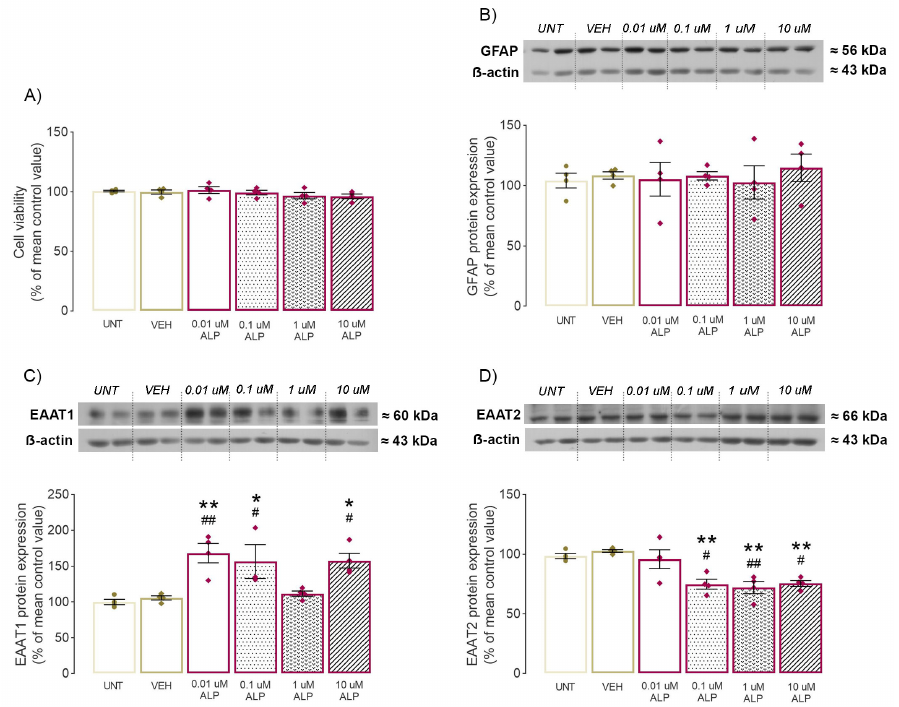
Figure 4. Effect of 48 - h treatment with increasing ALP doses on primary cortical astrocyte culture. ( A ) Results of MTT assay used for determination of cell viability, ( B – D ) representative immunoblots and quantitative data of Western blot analysis of target proteins expression whole cell fraction of primary cortical astrocyte culture: ( B ) GFAP, ( C ) EAAT1, ( D ) EAAT2. Data were statistically analyzed by two-tailed t -test ( A ) or one-way ANOVA ( B – D ) and expressed as percentage of the mean values of CONT group ± SEM (dots in the graphs represent values of individual animals). Symbols indicate significant differences between respective group and CONT (* p < 0.05, ** p < 0.01) or VEH group (# p < 0.05, # p < 0.01); samples per group: 4.